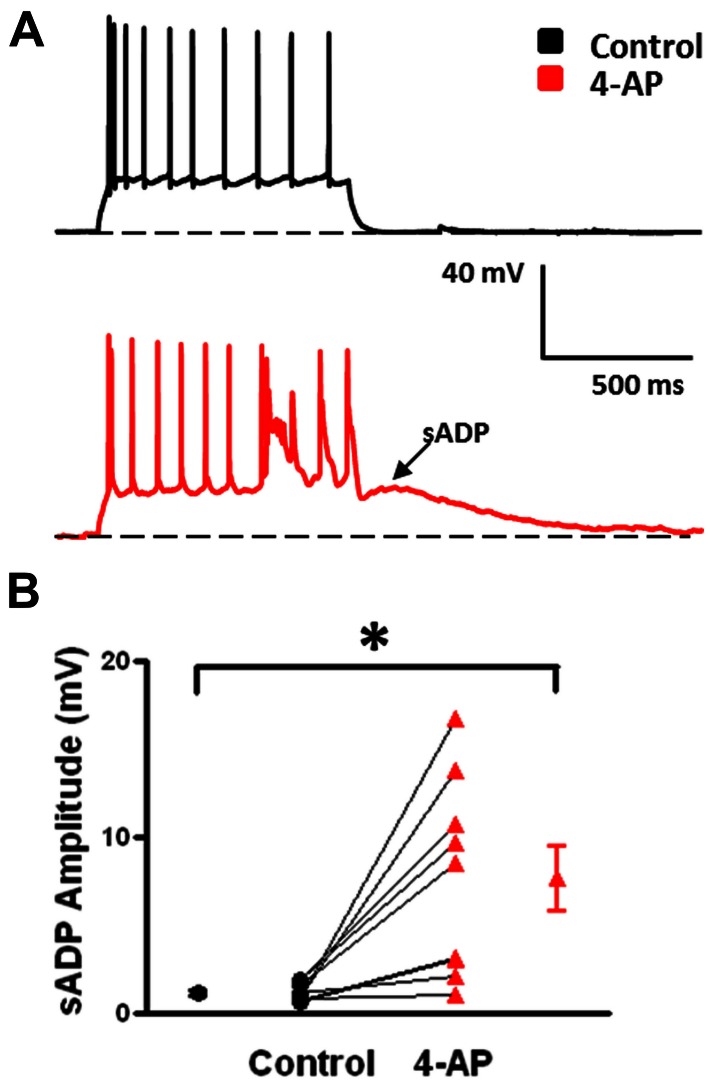
Emergence of slow afterdepolarizations (sADPs) in b-AC MCs in presence of 4-AP. (A) Representative response of a L2/3 b-AC MC to a 475 pA depolarizing current pulse before (black) and after (red) bath application of 4-AP. Following application of 4-AP, a sADP was observed following repetitive firing. (B) Summary plot showing that a significant s-ADP was observed in all b-AC MCs in presence of 4-AP (n = 10). *p < 0.05.